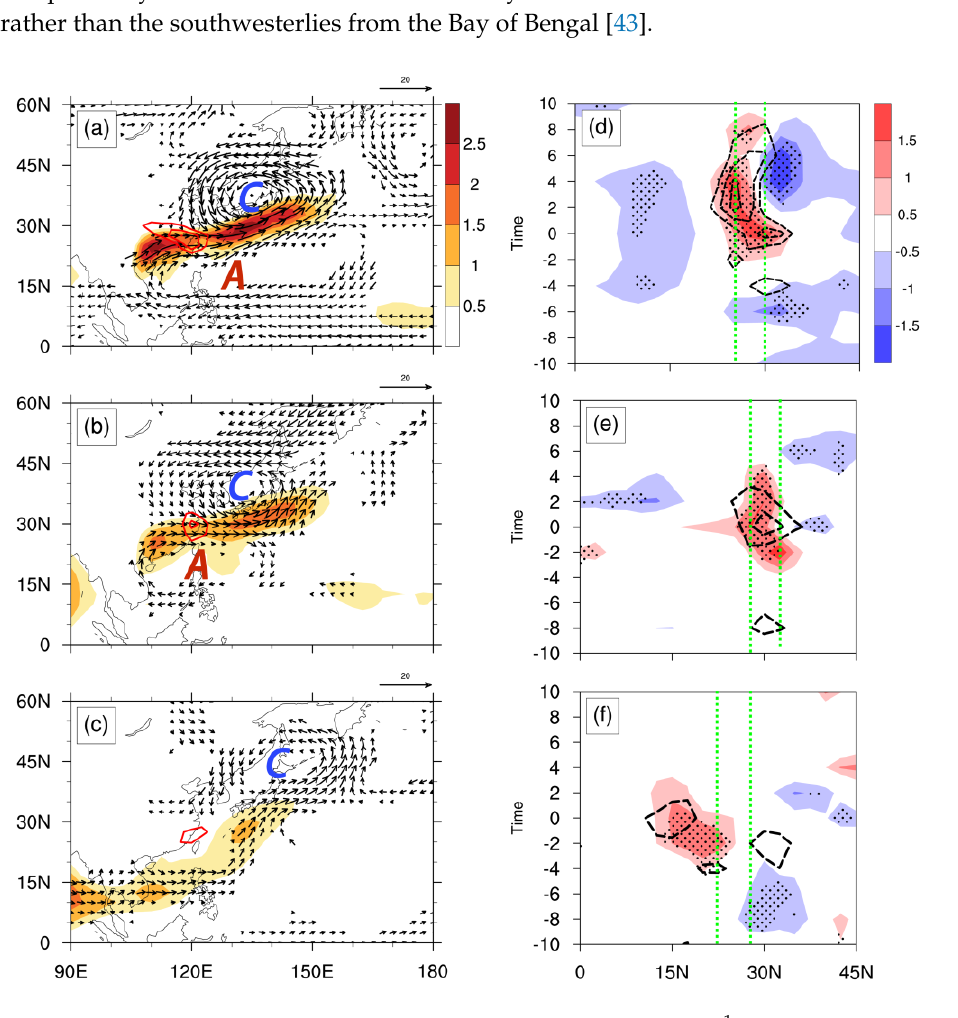
Figure 8. Composite averaged wind anomalies at 850 hPa (vector; units: m s −1 ), normalized anomalies of total moisture flux (shading, with interval of 0.5 standard deviation) and the convergence of moisture flux (red contours are from −3 × 10 −8 to −6 × 10 −8 s −1 with interval of −3 × 10 −8 s −1 ) in ( a ) EAP/SR-C; ( b ) EAP-S; and ( c ) SR-S events. Time-latitude cross-section (115–125° E) of moisture flux (shading, with interval of 0.5 standard deviation) and moisture flux convergence (black dashed contours are from −2 × 10 −8 to −6 × 10 −8 s −1 with interval of −2 × 10 −8 s −1 ) in ( d ) EAP/SR-C; ( e ) EAP-S; and ( f ) SR-S events from day −10 to day 10.